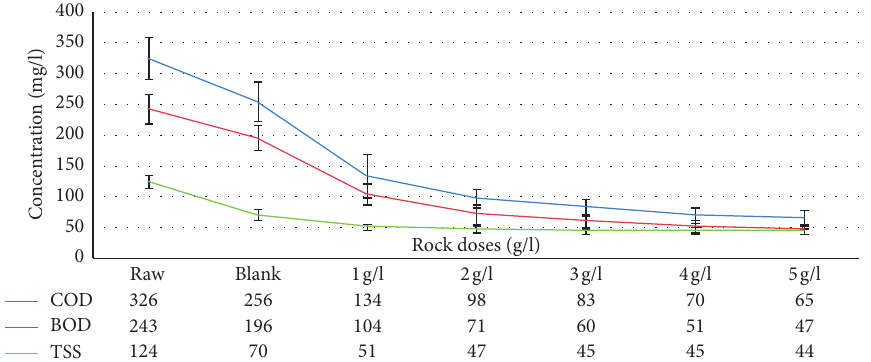
Figure 3: Depletion of the COD concentration with the rock dose.